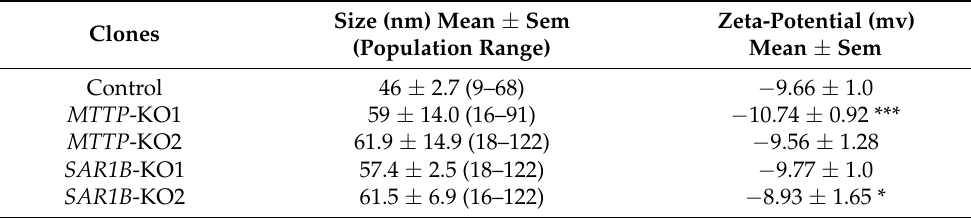
Table 1. Physicochemical characteristics of particles secreted by Caco-2 cells.